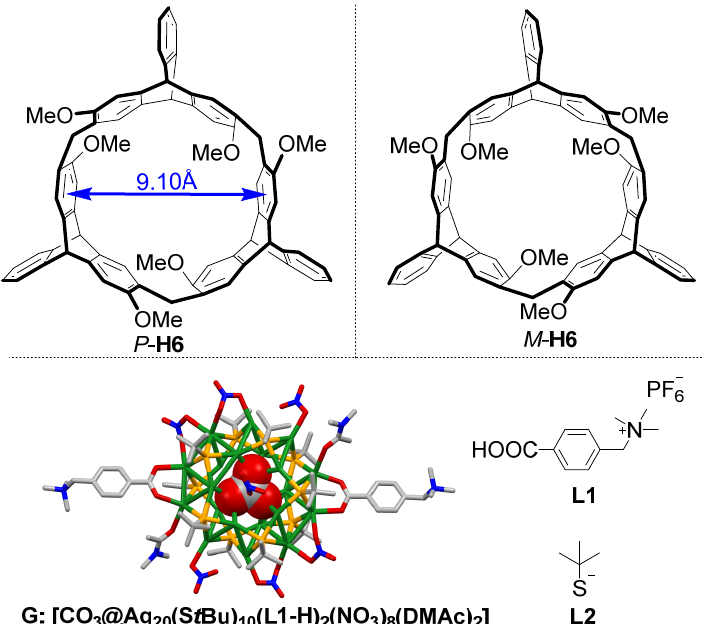
Figure 1. Structures of the chiral macrocyclic hosts P - H6 / M - H6 , the silver cluster G , and the ligands L1 and L2 (H atoms and solvent molecules of G were omitted for clarity; color legend: Ag, green; S, orange; C, gray; N, blue; O, red; L1 was designated as L1-H after L1 coordinated to Ag atoms with one proton lost).